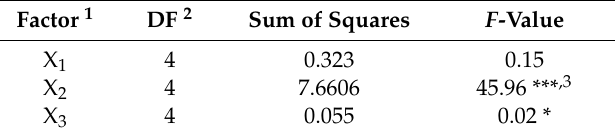
Table 2. Analysis of variance for chlorophyll a contents in the extracts of marine Spirulina maxima . DF 2